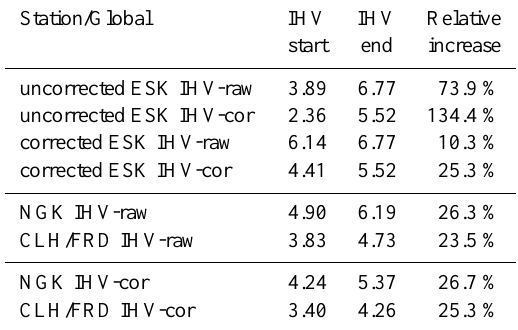
Table 4. Mean IHV-raw and IHV-cor values for ESK (calculated for 1912–2000) and the two other mid-latitude stations at the begin- ning (from start until 1922) and at the end (1979-2000) of the last century, and their relative